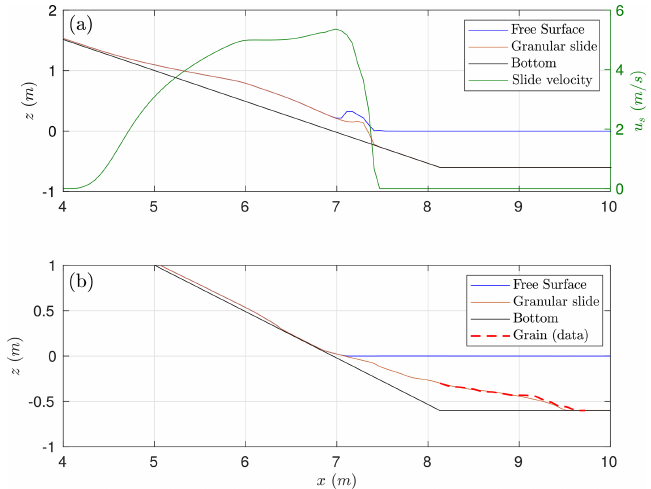
Figure 10. BP6 cross section at y = 0m. Panel (a) shows the location and velocity of the granular slide and the generated wave at time t = 0 . 4s from the triggering and (b) the final deposit location (at t = 20s).